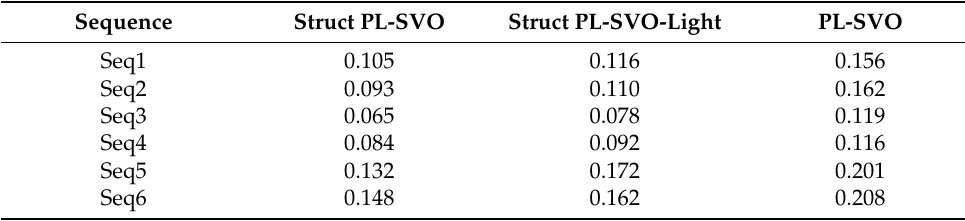
Figure 12. The aligned trajectories of different systems on x, y, and z axes separately. The distance indicates the current distance covered by the robot trajectory. ( a ) Floor 3 sequence 1. ( b ) Floor 1 sequence 3. ( c ) Parking lot sequence 5. Table 6. Relative RMSE errors in the ceiling